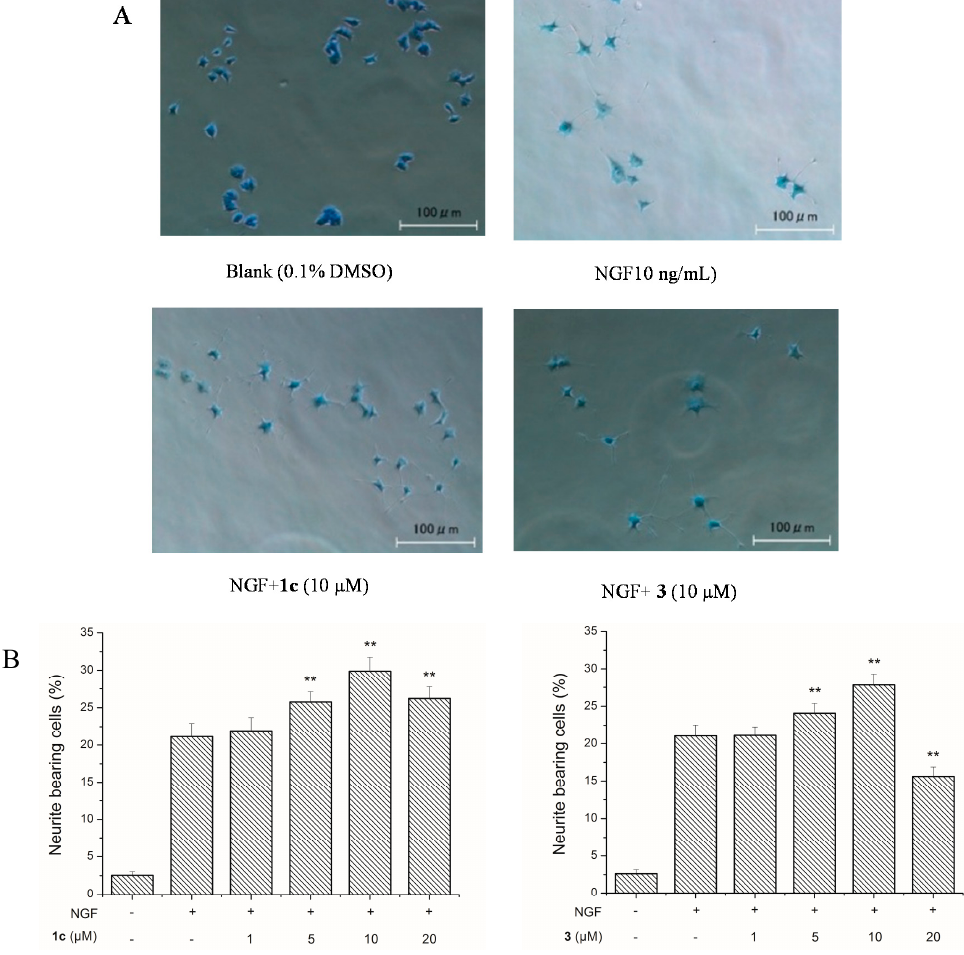
Figure 3. Neurite outgrowth-promoting activity of 1c and 3 in PC12 cells. ( A ) Morphology of PC12 cells; ( B ) Quantitative analysis of neurite outgrowth promoted by 1c and 4 . Compounds 1c and 3 (1, 5, 10, and 20 μ M) + NGF (10 ng/mL). Data are expressed as the means ± SD ( n = 3) (** p < 0.01 vs. NGF; Dunnett’s t test). In control experiments, the percentages of neurite-bearing cells were 21.11% ± 1.62% following incubation with 10 ng/mL of NGF after 48 h.